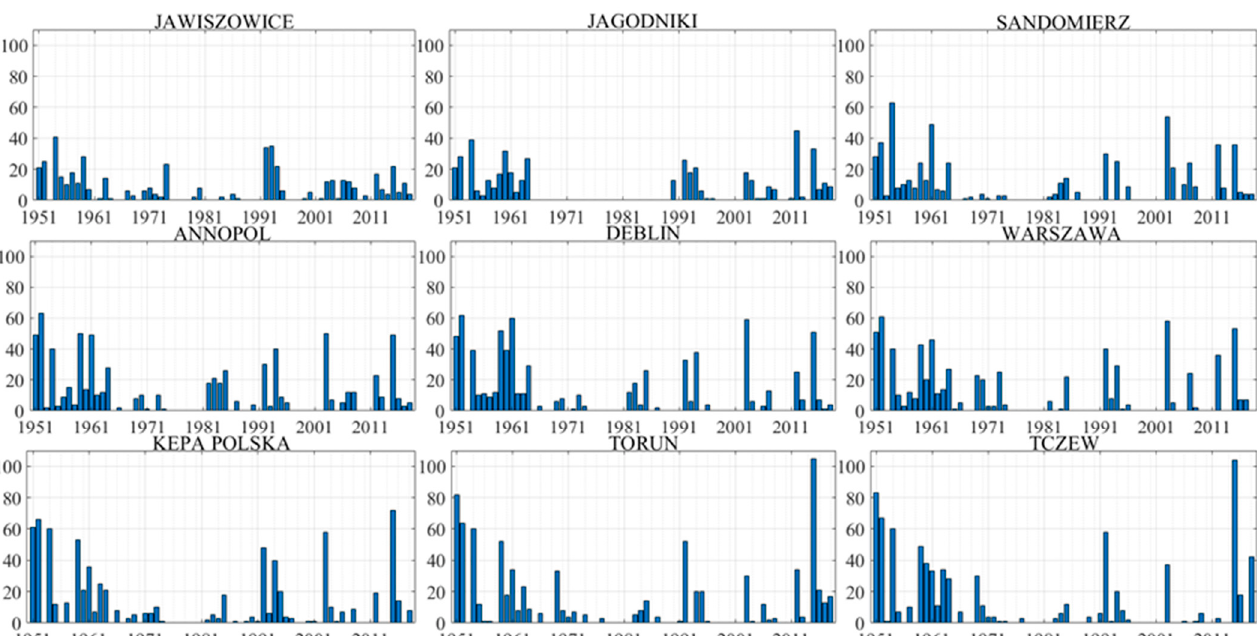
Figure 8. The longest period (number of days) with flow below the 0.05 quantile value (the 0.05 quantile value determined based on the whole analyzed period from 1 November 1950 to 31 October 2018).